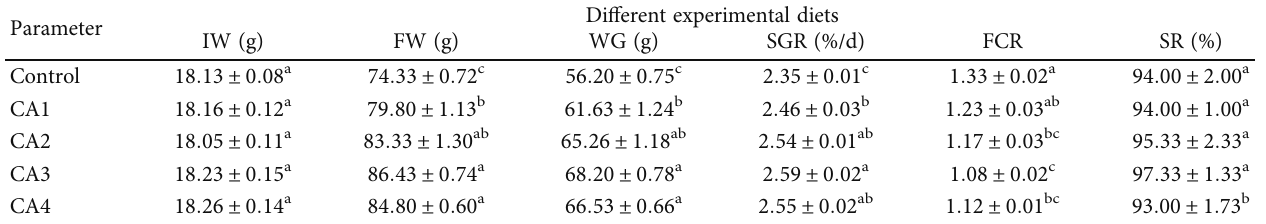
Di ff erent experimental diets